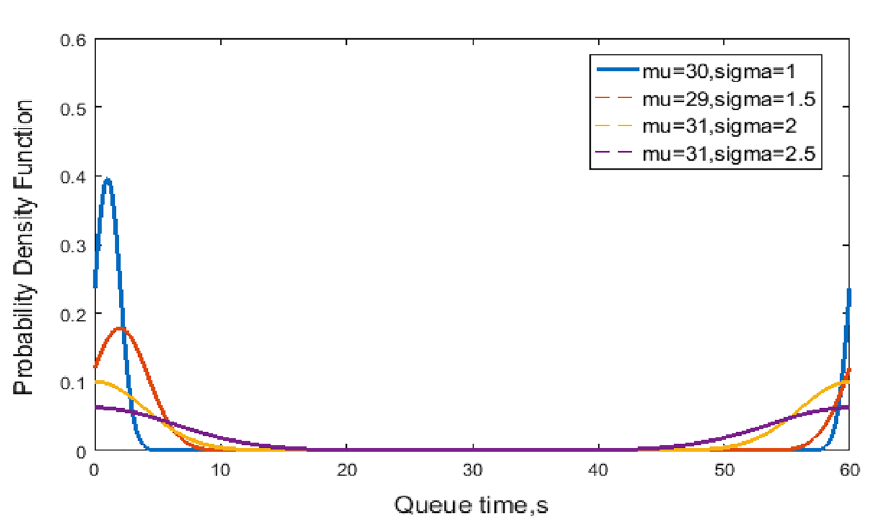
Figure 3. Truncated normal distribution of queue